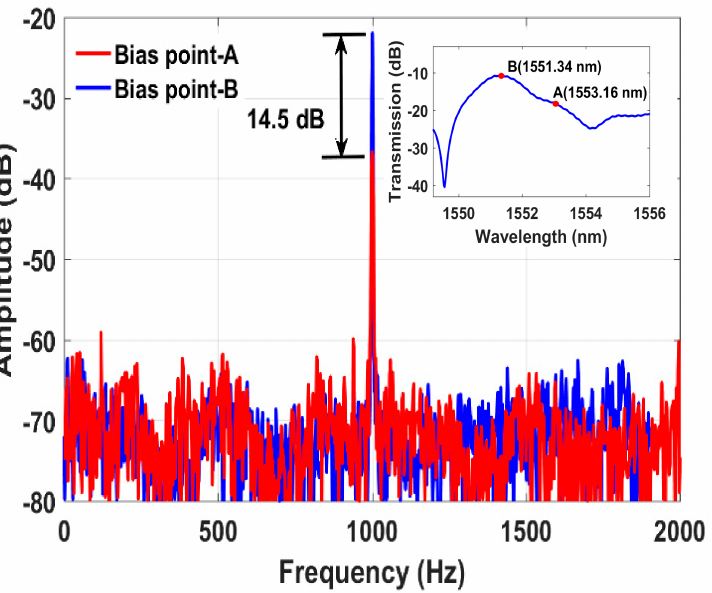
Figure 3. Measured vibration frequency (1 kHz) spectrums at the laser wavelength positioned at two biasing points of the SMS transmission spectrum (inset: SMS sensor transmission